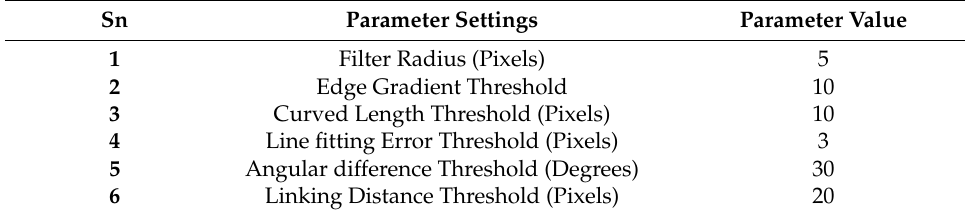
Table 4. Software specification for lineament